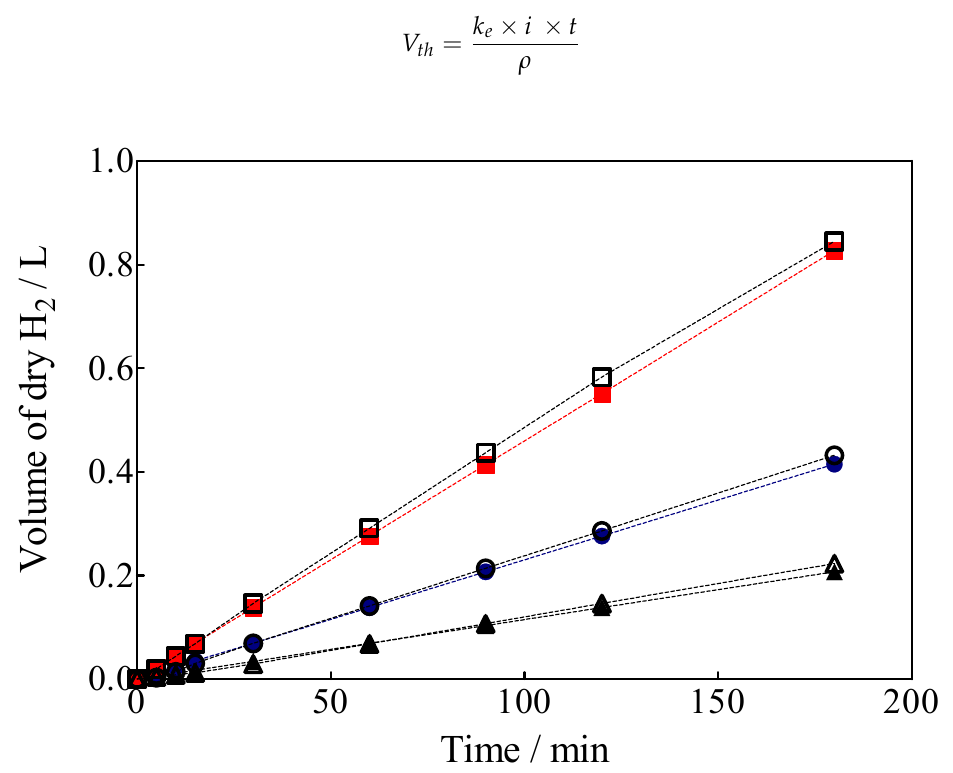
Figure 10. Volume of green H 2 produced in a hybrid process with simultaneous Calcon EO in the anodic compartment with the BDD anode, applying ( ▲ , ∆ ) 7.5 mA cm − 2 , ( ● , ○ ) 15 mA cm − 2 and ( ■ , ) 30 mA cm − 2 . Empty circles: theoretical values; solid circles: experimental values. Where ke = ( M / n F) is the electrochemical equivalent (kg A − 1 s − 1 ), n is the electron number (2 for H 2 ), F is the Faraday constant (96,487 C mol − 1 ), M is the molar mass of H 2